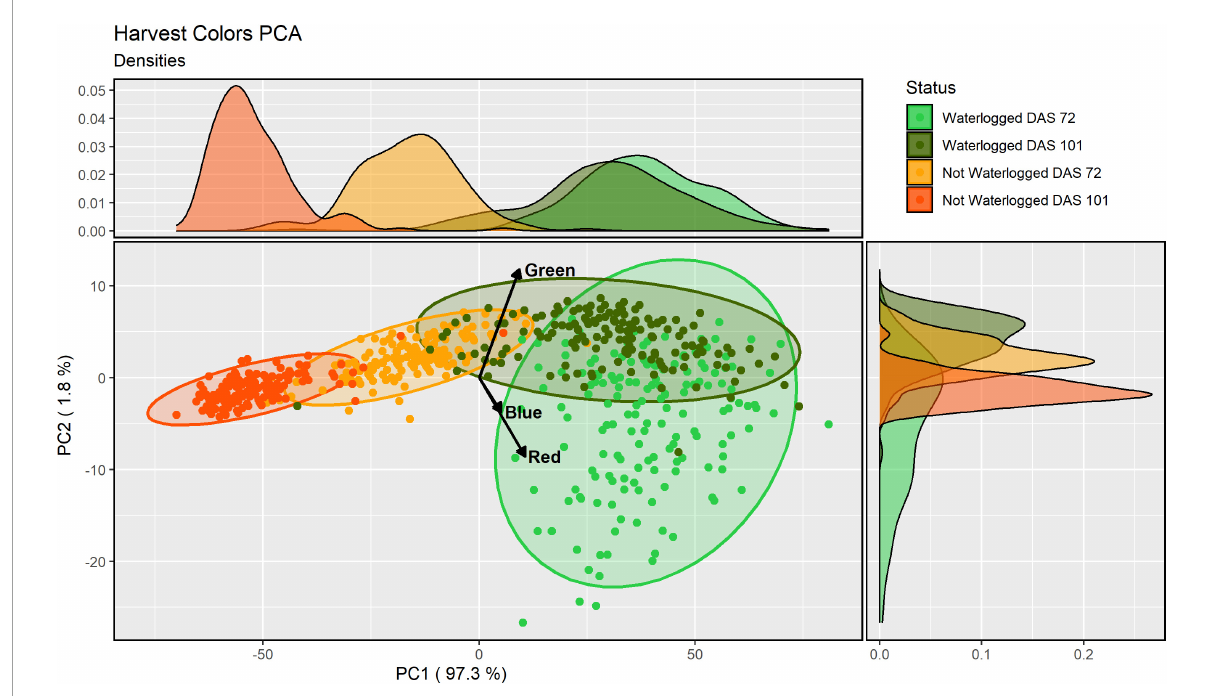
FIGURE5 Principal component analysis (PCA)-analysis of the three RGB-hues of the harvested material for all cores, water status and harvest (DAS 72 and 101) as identified by the image analysis. Each ellipse represents a 95% confidence ellipse for each group. Side graphs shows the relative densities of each PCA axis and grouping, with the area under each curve representing the entire group distribution.